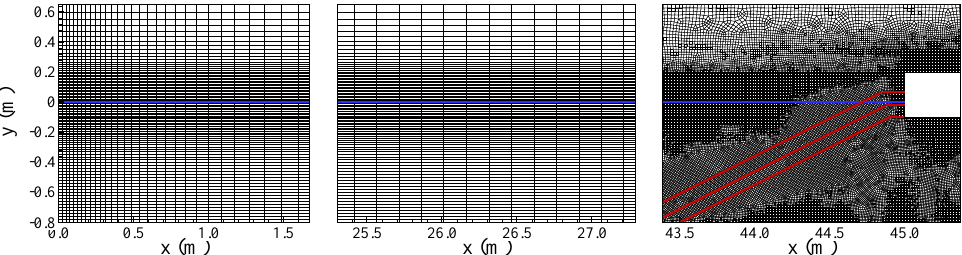
0.0 0.5 x (m) Figure 21. Details of the mesh near the wave-maker, along the flume and in the proximity of the rubble mound breakwater. The blue line indicates the SWL and the red ones the limits of the porous layers.